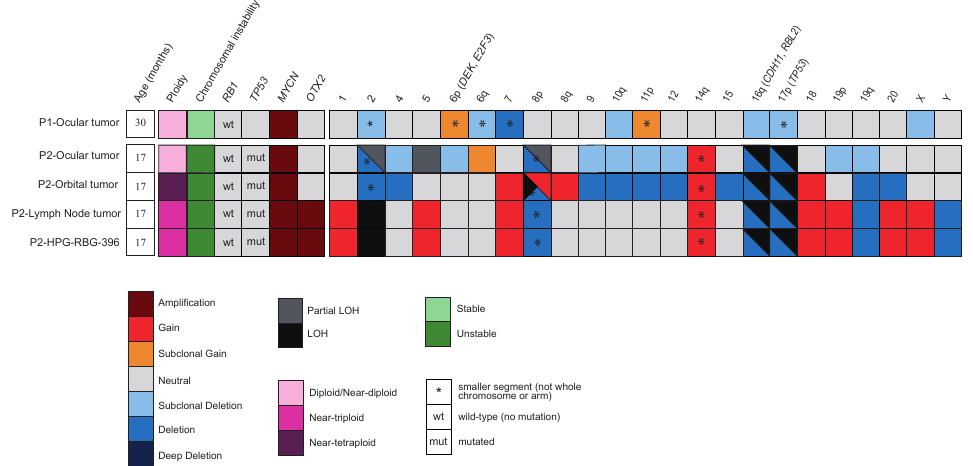
Figure 3. Each row represents individual samples and the rectangular boxes correspond to the status of each of the main characteristics depicted. Boxes are partitioned if more than one relevant feature coexists. Patient 1 (P1) and Patient 2 (P2) ocular tumors were analyzed with Oncoscan array and Sanger sequencing, while P2 metastases were studied by WES. Ploidy is normal for P1 ocular tumor, whereas it is abnormal in P2, even in the ocular tumor in which a distinction between tetraploid or diploid was not possible. TP53 and RB1 somatic mutations are depicted along with focal amplifications on MYCN and OTX2 . Each number on top of the boxes represents a chromosome or chromosome arm where at least a single CNA has been found. Relevant retinoblastoma driver genes are between brackets. Copy number gains are shown in red, and blue represents losses, while the intensity of the color shade is proportional to the value of the log-ratio